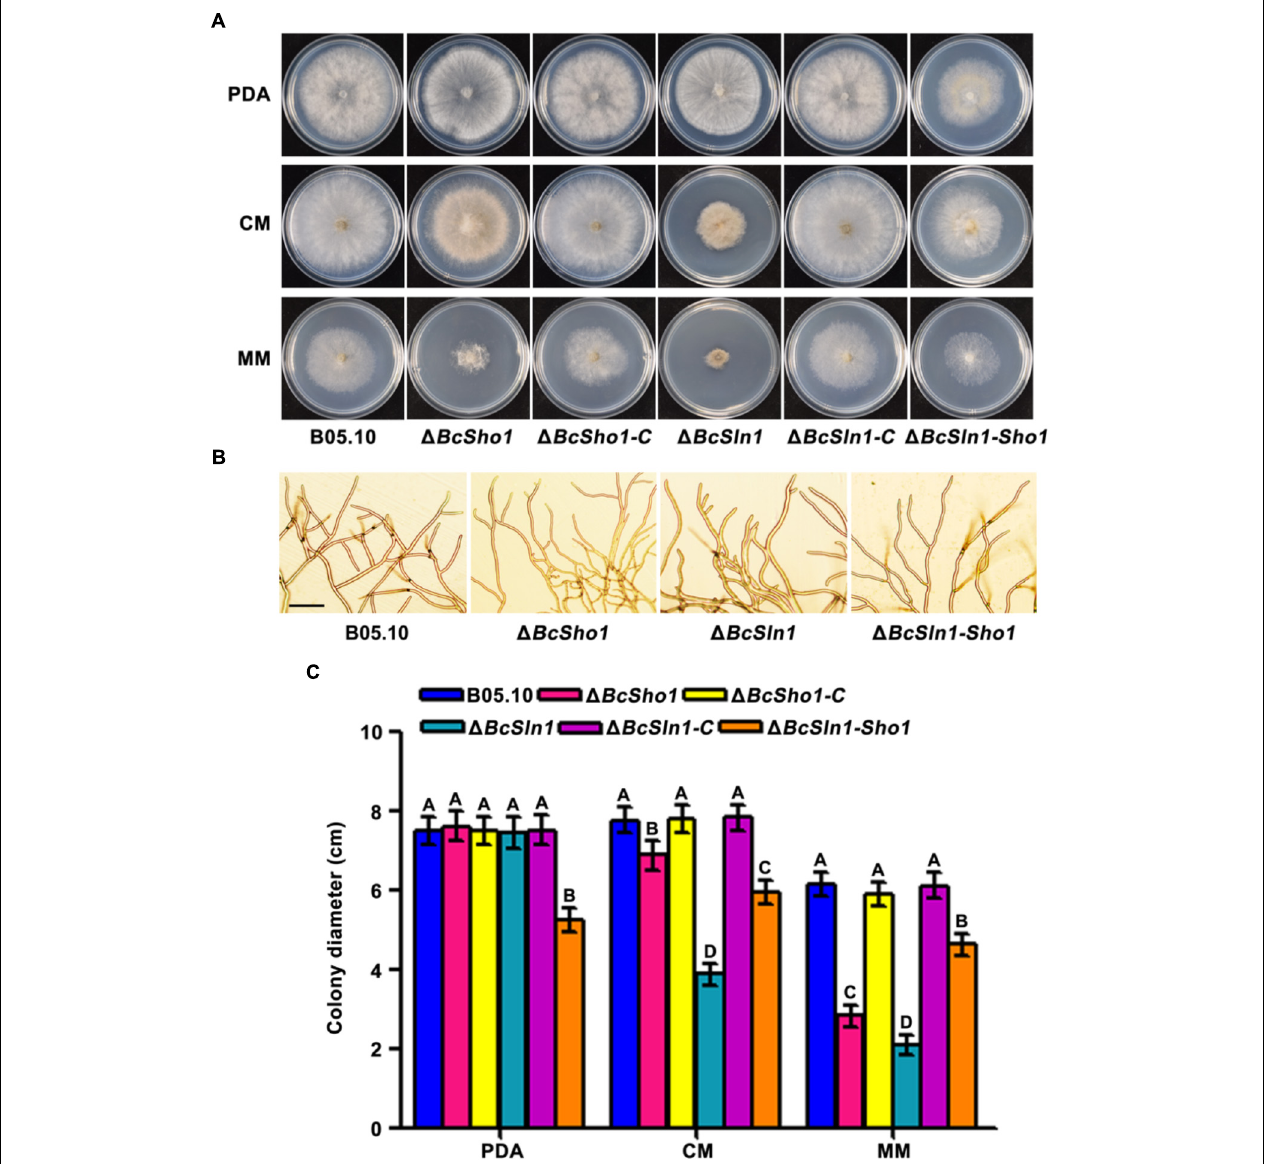
FIGURE 2 | Roles of BcSHO1 and BcSLN1 in vegetative growth. (A) Colony morphology of the wild-type B05.10, the single deletion mutants (cid:49) BcSho1 and (cid:49) BcSln1 , the double deletion mutant (cid:49) BcSln1-Sho1 , and the complemented mutants (cid:49) BcSho1-C and (cid:49) BcSln1-C on PDA, CM and MM media at 25 ◦ C for 4 days. (B) Hyphal morphology of each strain growing on PDA plates. Bar, 100 µ m (C) Colony diameters were measured in each independent biological experiment and statistically analyzed by Duncan analysis. Bars represent standard errors from three replications. Values on the bars followed by the same letter are not significantly different at P =